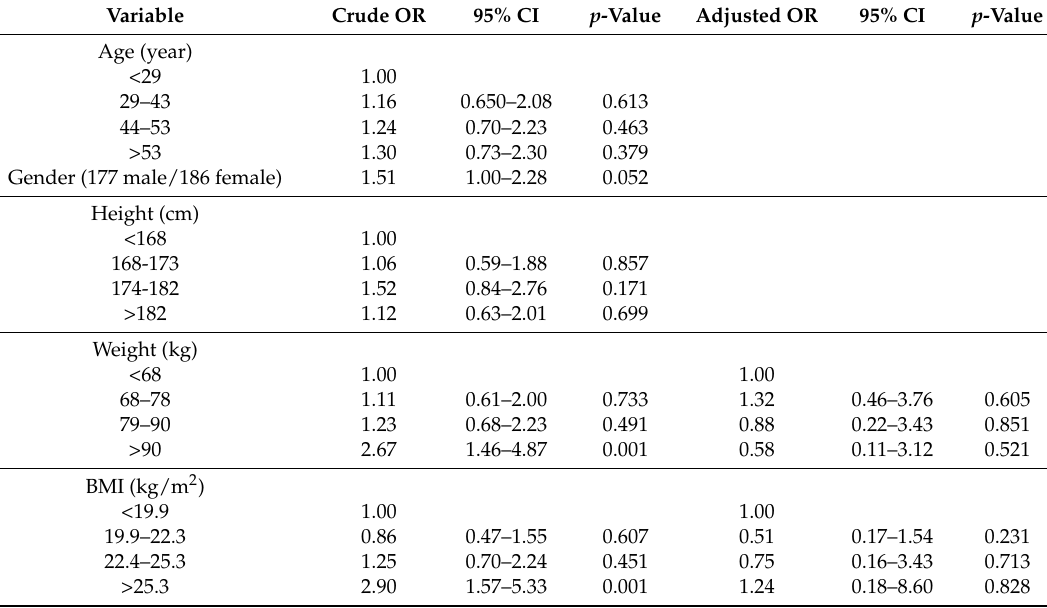
Table 5. Subject characteristics in relation to low and high zonulin